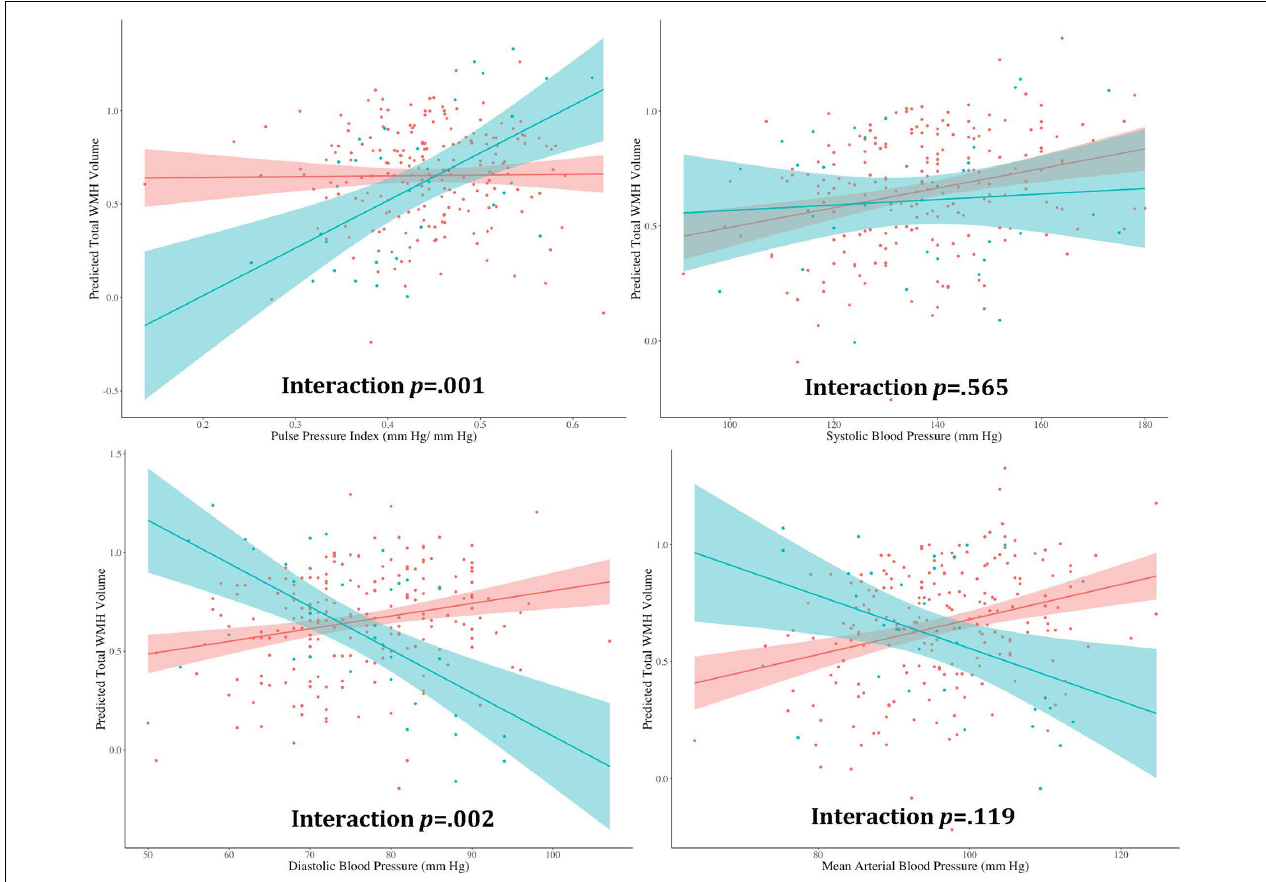
FIGURE 1 | The effect of different vascular hemodynamic measures on the relationship between diabase status and total white matter hyperintensity burden in older adults with mild cognitive impairment. Note. DM, diabetes mellitus; WMH, white matter hyperintensity. Within the MCI group, separate hierarchical multiple linear regression models evaluated the interactive effect of diabetes status and each vascular hemodynamic measure on total WMH volumes. All models were adjusted for age, sex, body mass index, intracranial volume, cerebrospinal fluid amyloid beta positivity, and apolipoprotein E ε 4 status. PPi significantly modified the relationship between diabetes status and total WMH burden (interaction p = 0.001), such that PPi values were associated with greater WMH burden in older adults with MCI and diabetes ( β = 1.99, S.E. = 0.943, 95% CI: 0.051–3.928; p = 0.045, partial r = 0.382), but not their non-diabetes counterparts ( p > 0.05). Diastolic BP also significantly interacted with diabetes status on total WMH volume (interaction p = 0.002). Here, greater diastolic BP values were associated with greater WMH volumes in non-diabetic older adults with MCI ( β = 0.008, S.E. = 0.003, 95% CI: 0.155, 2.438; p = 0.016, partial r = 0.382). In contrast, no significant association was observed between diastolic BP values and WMH burden in their diabetic counterparts ( p > 0.05). No significant interaction effects were observed with systolic BP or MABP (interaction p s >